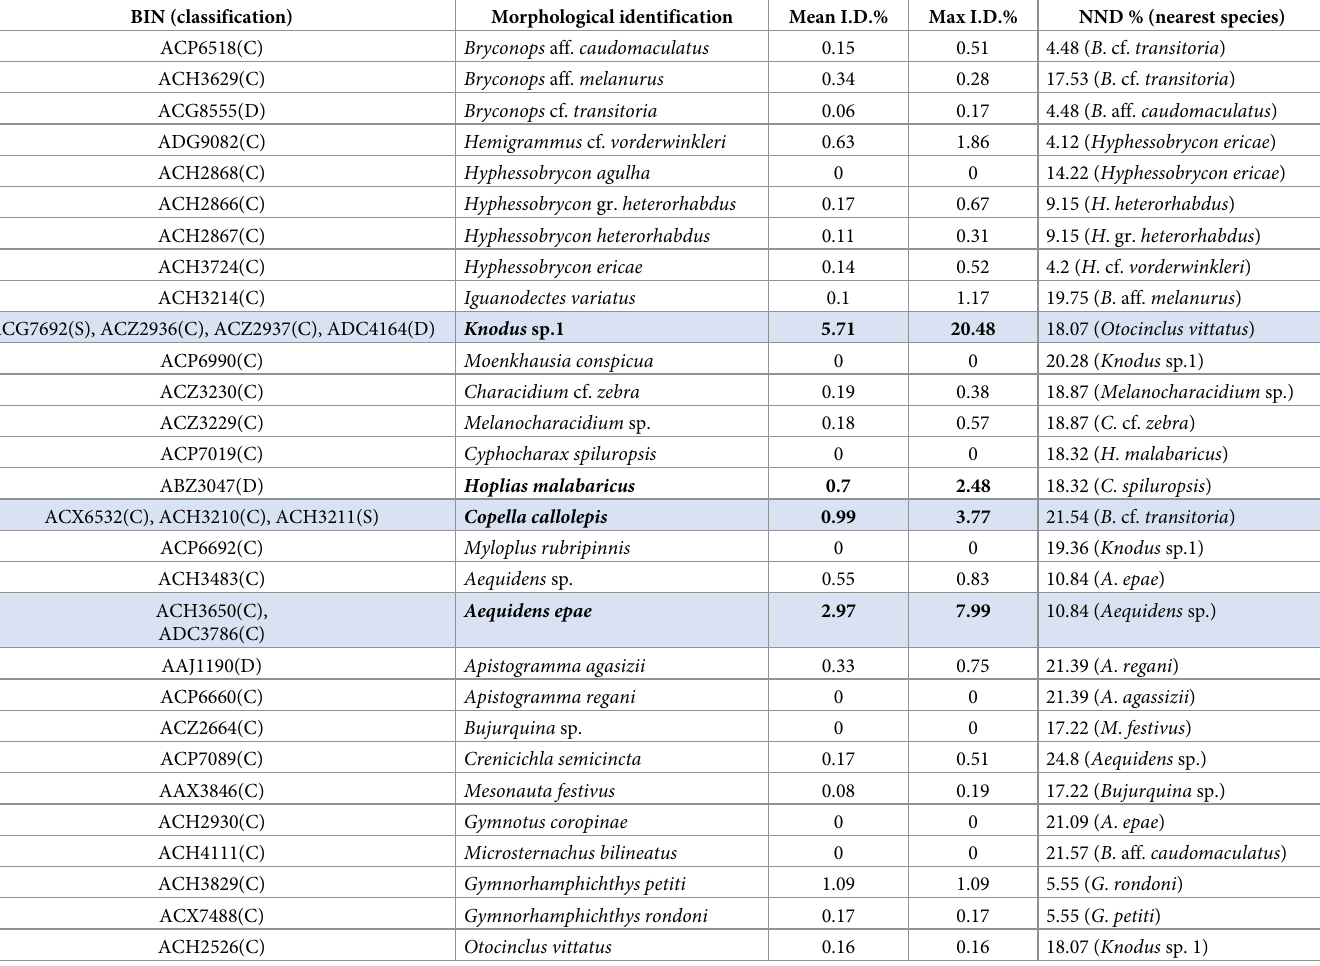
Table 3. BIN classification and measures of intraspecific genetic distances (I.D.) and nearest neighbor distances (NND) of fish species from the streams of the lower Tapajo´s River. Species with high intraspecific divergence ( > 2%) were assigned in bold type. BIN classification follows—C (concordant), D (discordant) and S (singleton). Species complex were illuminated with blue shadow. The distances were estimated following Kimura-2-parameter